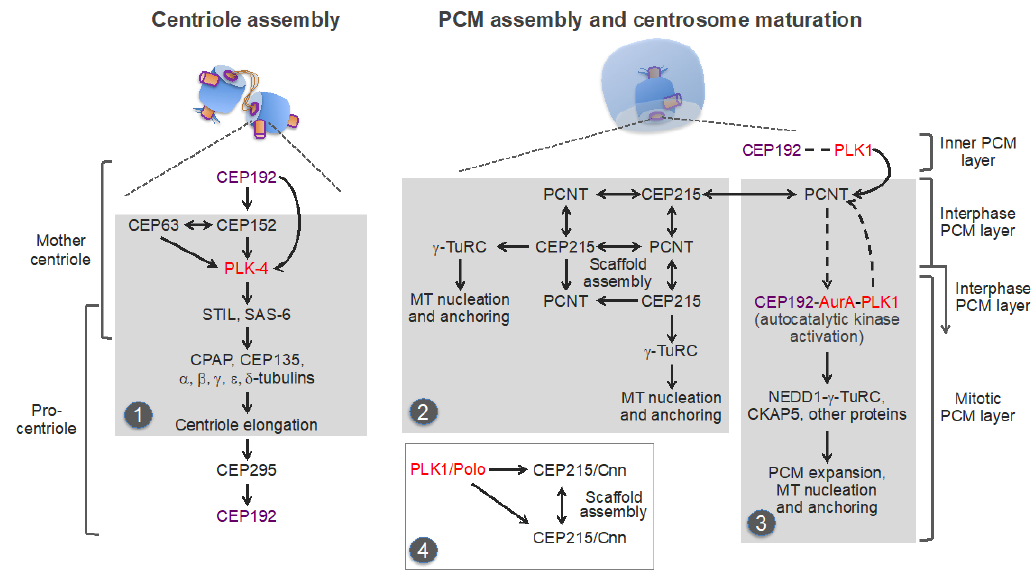
Figure 5. Molecular pathways underlying centriole and pericentriolar material (PCM) assembly in vertebrates. Protein kinases are in red. The centrosomal protein of 192 kDa (CEP192) and the inner (proximal to the centriole) PCM layer, which contains CEP192 and polo-like kinase 1 (PLK1), are in purple. Distinct modules, which are repurposed and used in centrosome-independent processes, are highlighted in grey. Module 1: Basal body assembly module used in multiciliated cells. Module 2: pericentrin (PCNT)-CEP215 module used for the assembly of non-centrosomal microtubule (MT)-organizing centers (MTOCs) in postmitotic cells. Module 3: A putative PCNT-CEP192 module used for the assembly of acentriolar mitotic MTOCs in mouse oocytes and early embryos. This module relies on the CEP192-mediated, autocatalytic mechanism of Aurora A (AurA)-PLK1 activation, and PCM protein recruitment. Dashed arrows/lines indicate inferred interactions/effects that need to be experimentally validated. Module 4: PCM scaffold assembly module used in D. melanogaster cells. STIL: SCL-interrupting locus protein [anastral spindle 2 (Ana-2) in D. melanogaster ; spindle assembly abnormal protein 5 (SAS-5) in C. elegans ]; γ -TuRC: γ -tubulin ring complex; CPAP: centrosomal P4.1-associated protein [also known as centromere protein J (CENPJ); SAS-4 in D. melanogaster and C. elegans ]; NEDD1: developmentally down-regulated protein 1; CKAP5: cytoskeleton-associated protein 5 [also known as colonic and hepatic tumor overexpressed protein (chTOG) and Xenopus MT-associated protein of 215 kDa (XMAP215)]. See text for details.